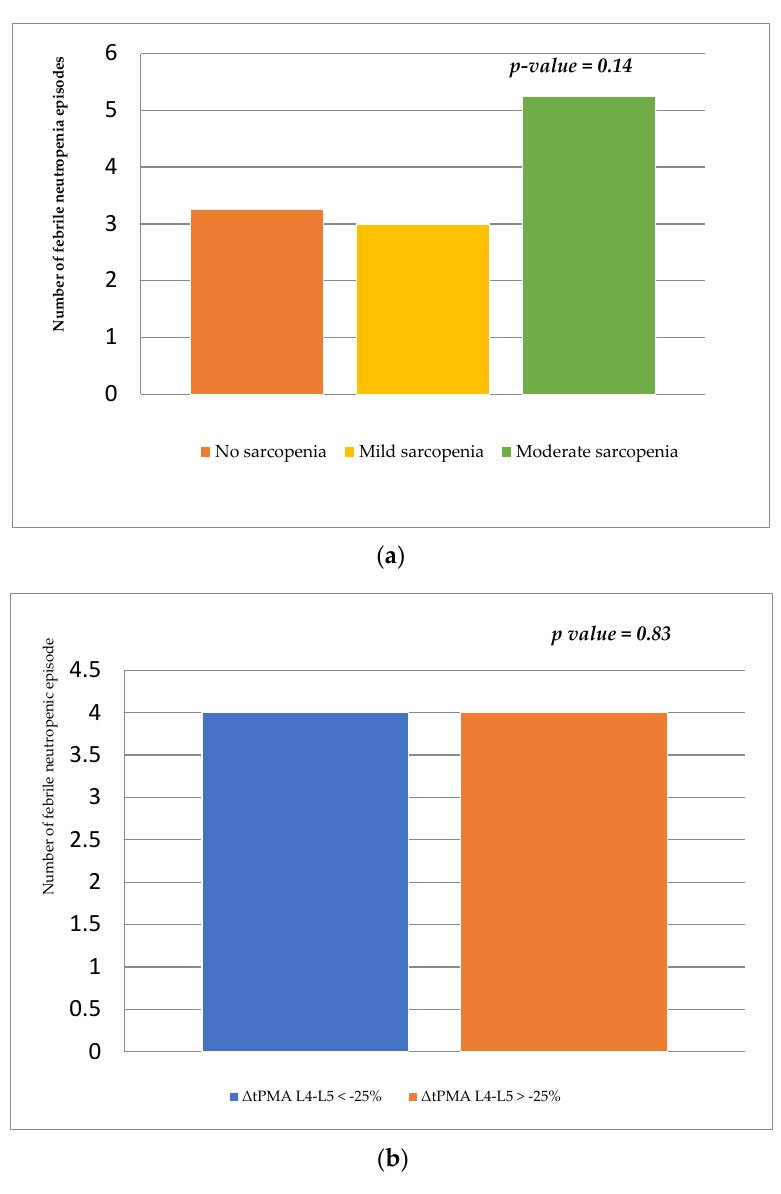
Figure 2. ( a ) Number of febrile neutropenic episodes in nonsarcopenic, mildly sarcopenic, and moderately sarcopenic patients at diagnosis. ( b ) Number of febrile neutropenic episodes in the patients with Δ tPMA L4–L5 < − 25% and patients with Δ tPMA L4–L5 > − 25%.